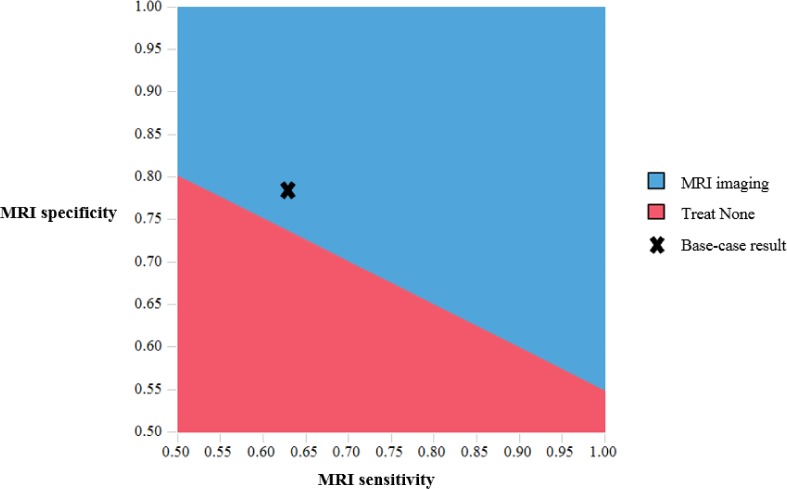
Two-way sensitivity analysis results for MRI sensitivity and specificity (for identifying stroke onset time of <4.5 hours), assuming willingness-to-pay for health of $100,000/QALY.The MRI-based strategy is optimal in the blue region, which includes the base-case result (marked by an “X”); the no treatment strategy is optimal in the red region given some other combinations of MRI sensitivity and specificity. The line separating the blue and red regions has an angle <45 degrees, which indicates that the results are more influenced by specificity than sensitivity.